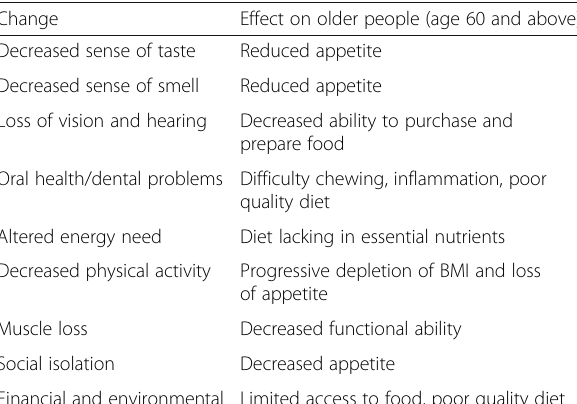
Table 1 Effects of changes on aging